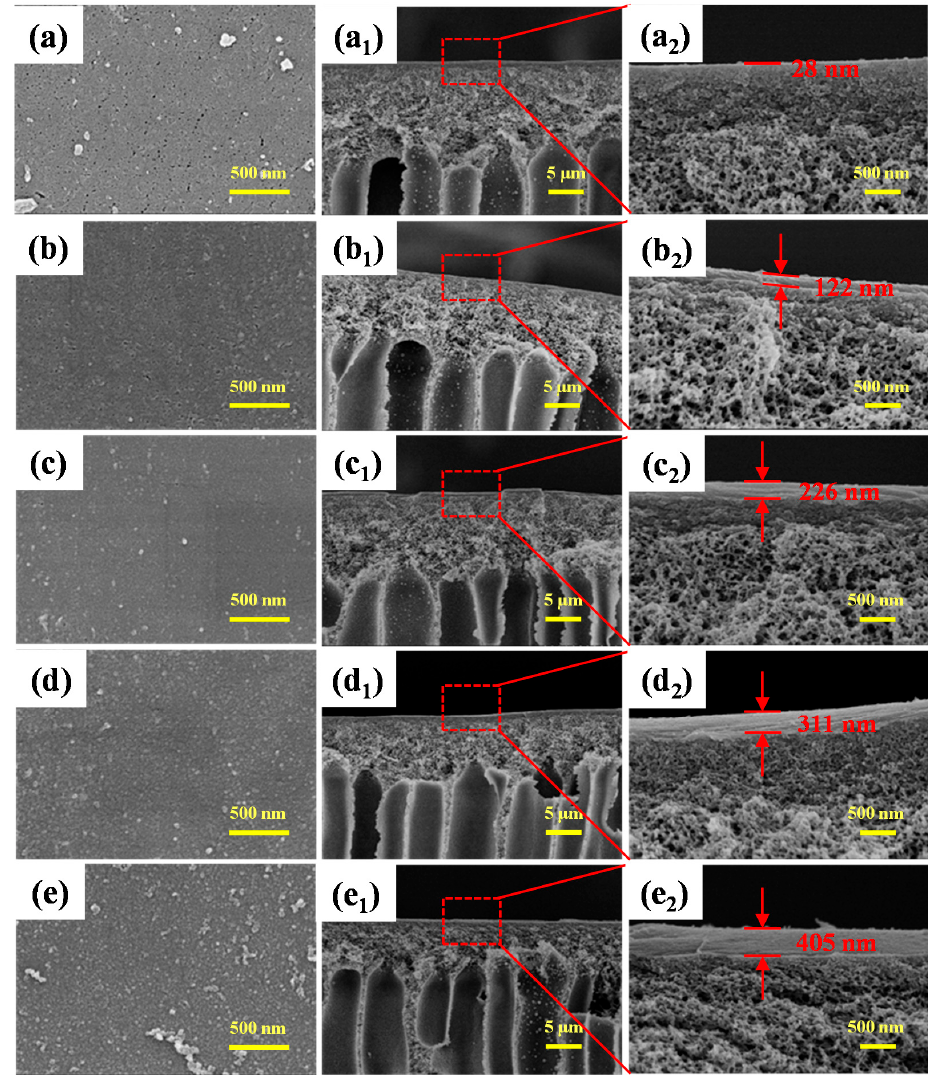
Figure 4. SEM images of the top surface and cross-section morphologies of PES/ Fe-TA-PEI mem- branes with different PEI concentrations (( a – a 2 ) 0, ( b – b 2 ) 0.5, ( c – c 2 ) 1.0, ( d – d 2 ) 1.5, and ( e – e 2 ) 2.0 g/L).